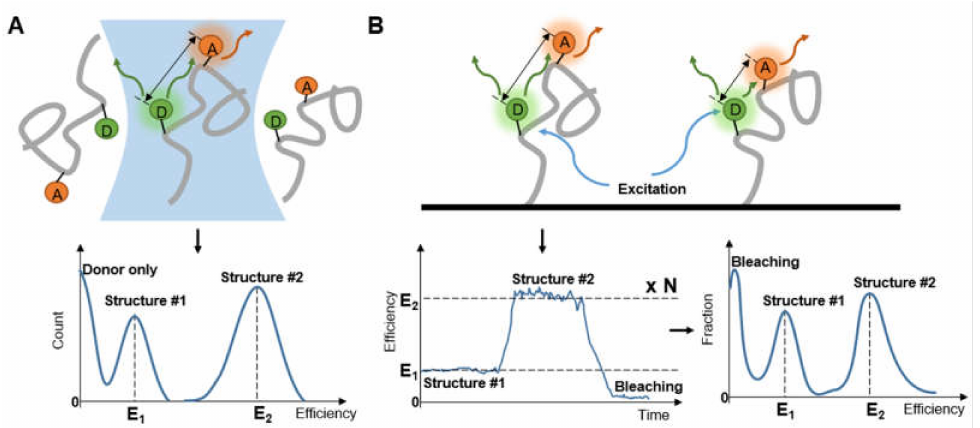
Figure 5. Observing ( A ) diffusing molecules and ( B ) immobilized molecules to obtain distribution of molecular